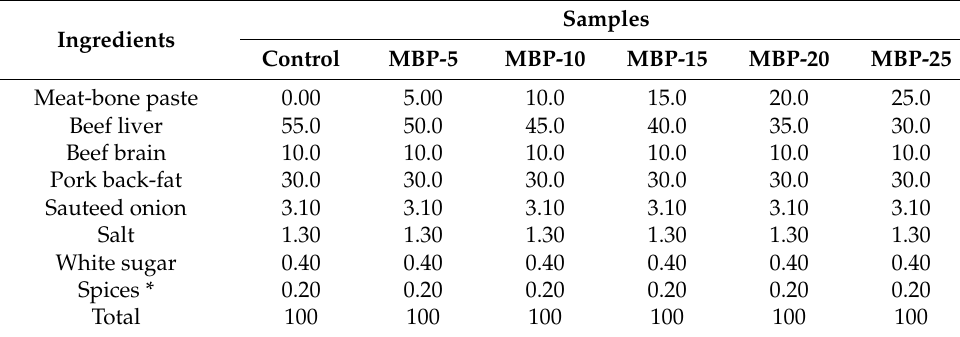
Table 1. Formulations of liver pâté with different amount of meat-bone paste (%). Ingredients